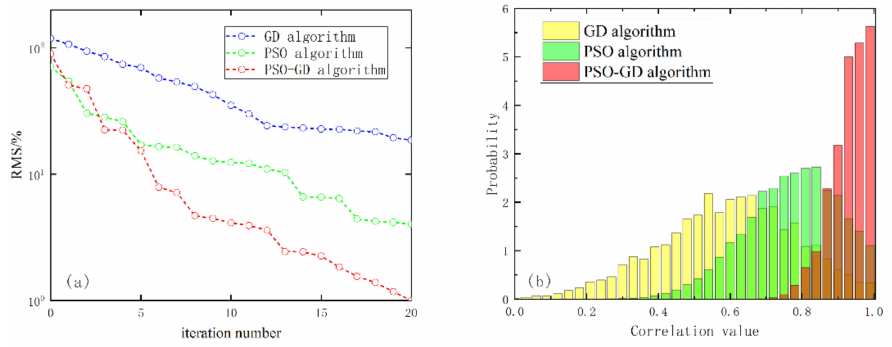
Figure 11. Fitting error curves and uncertainty analysis. ( a ) Fitting error curves. ( b ) uncertainty analysis.